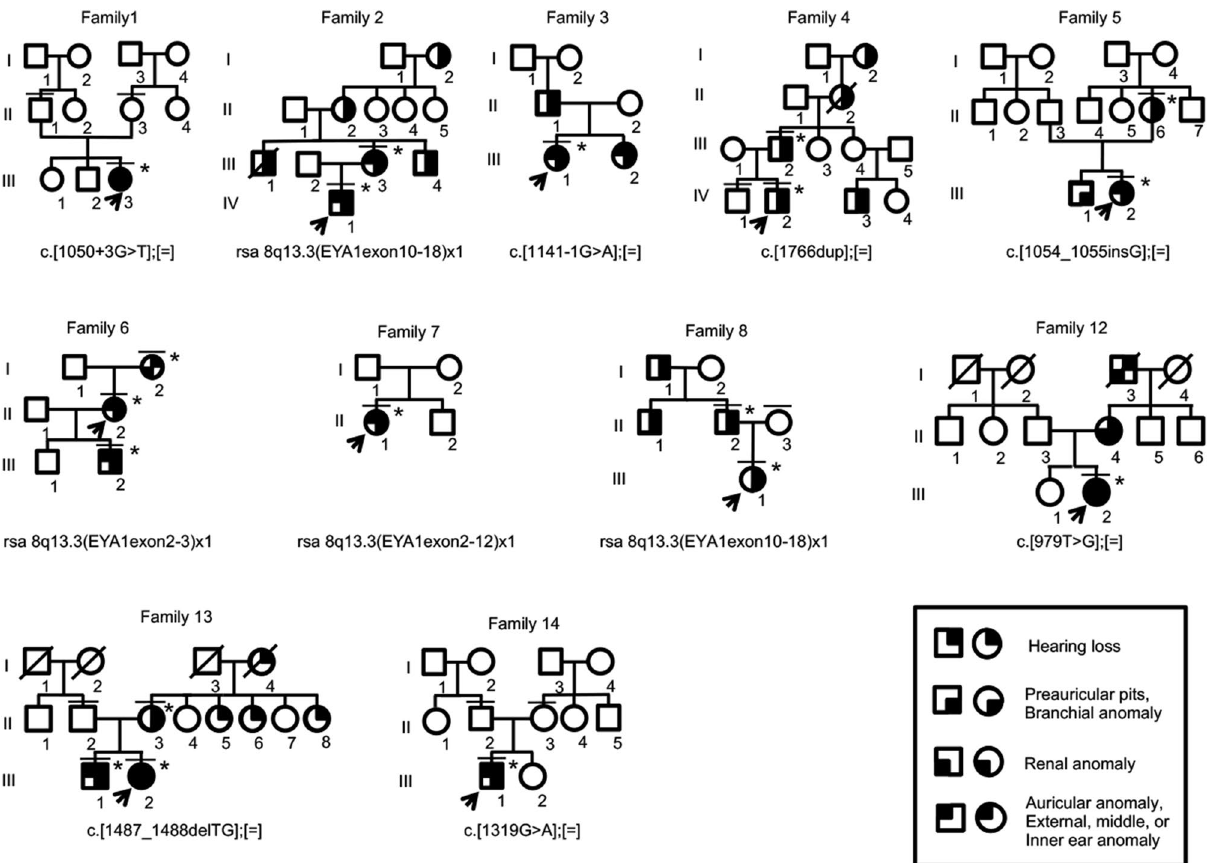
Figure 1. The pedigree of families with typical BOR syndrome and with P/LP variants. Arrows, probands; asterisks, patients with P/LP variants; crossbars, patients who underwent genetic